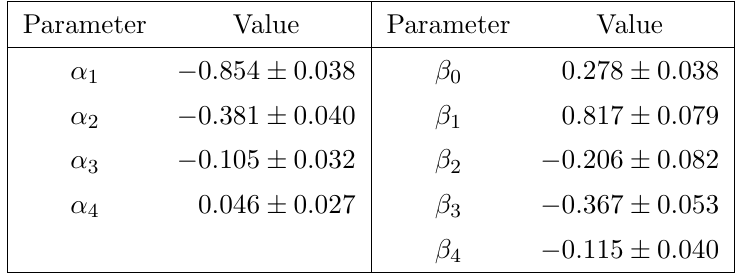
Table 8 . Coe(cid:14)cients used in the model-independent parameterisation of the scalar K(cid:25) mass- dependent